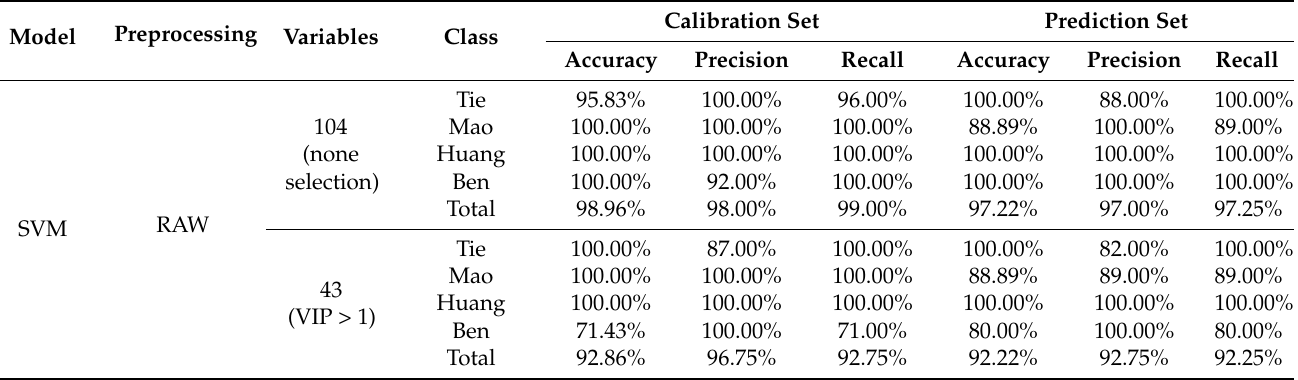
Table 1. Classification results for oolong tea (Tie represents Tieguanyin, Mao represents Maoxie, Huang represents Huangjingui, Ben represents Benshan. Total represents the average accuracy, precision and recall rate of each kind of